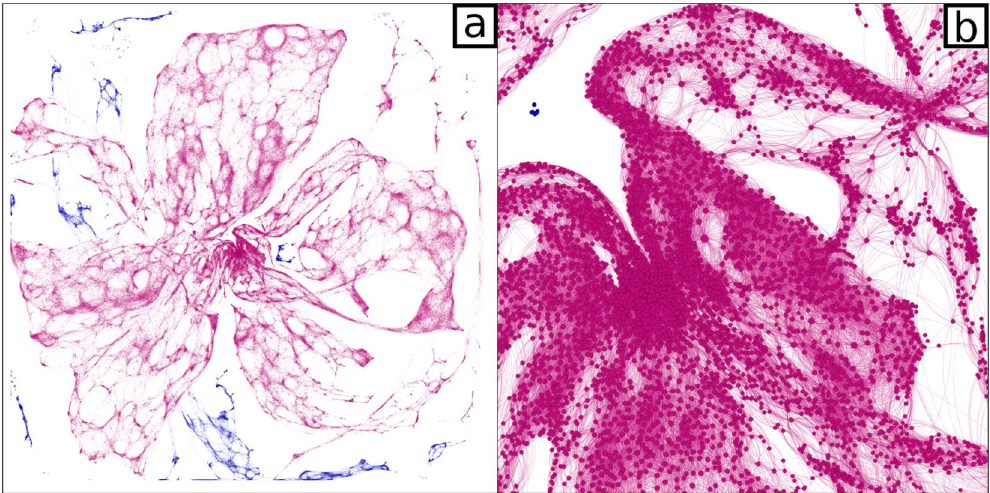
Figure 1. The network of olive orchard in Puglia. ( a ) Full view. ( b ) 10X zoom of the central region. Dots represent olive orchards, while links join all pairs of orchards at a distance of less than 1 km, depicting possible pathways of spread for Xylella fastidiosa. Edges and nodes belonging to the largest connected component (LCC) of the network are colored in magenta, while all other nodes and edges are colored in blue.